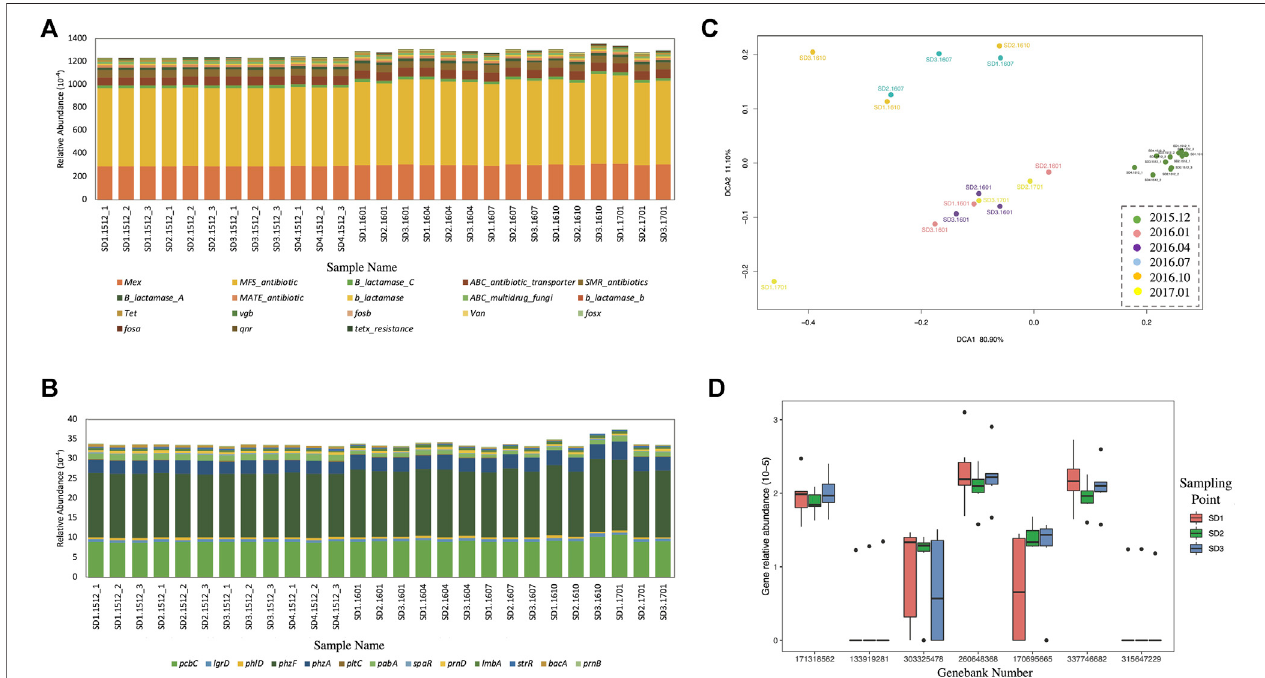
FIGURE 6 | ARGs and AMGs of sediment samples. (A) Relative abundance of ARGs at the gene family level. (B) Relative abundance of AMGs at the gene family level. (C) DCA at the Probe level. (D) Relative abundance of representative homologous genes of four β _lactame ARG families.